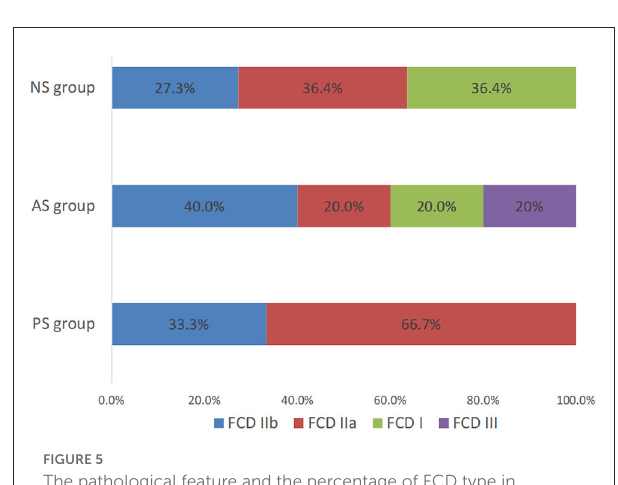
surgical outcomes, their histopathologic evaluations showed FCD II in 23 patients.